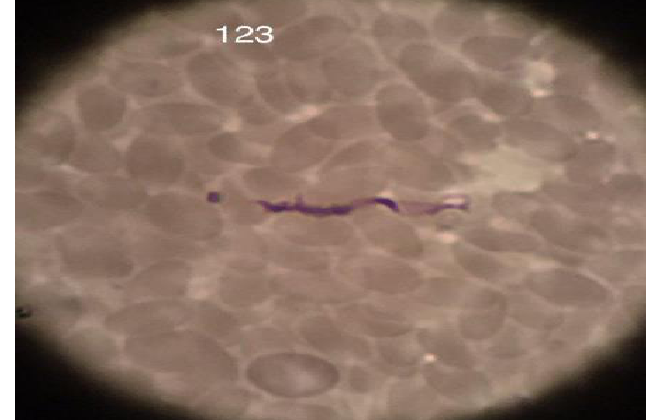
Figure 1. Infected blood film stained with Giemsa that examined by microscopy under oil immersion (100Χ)